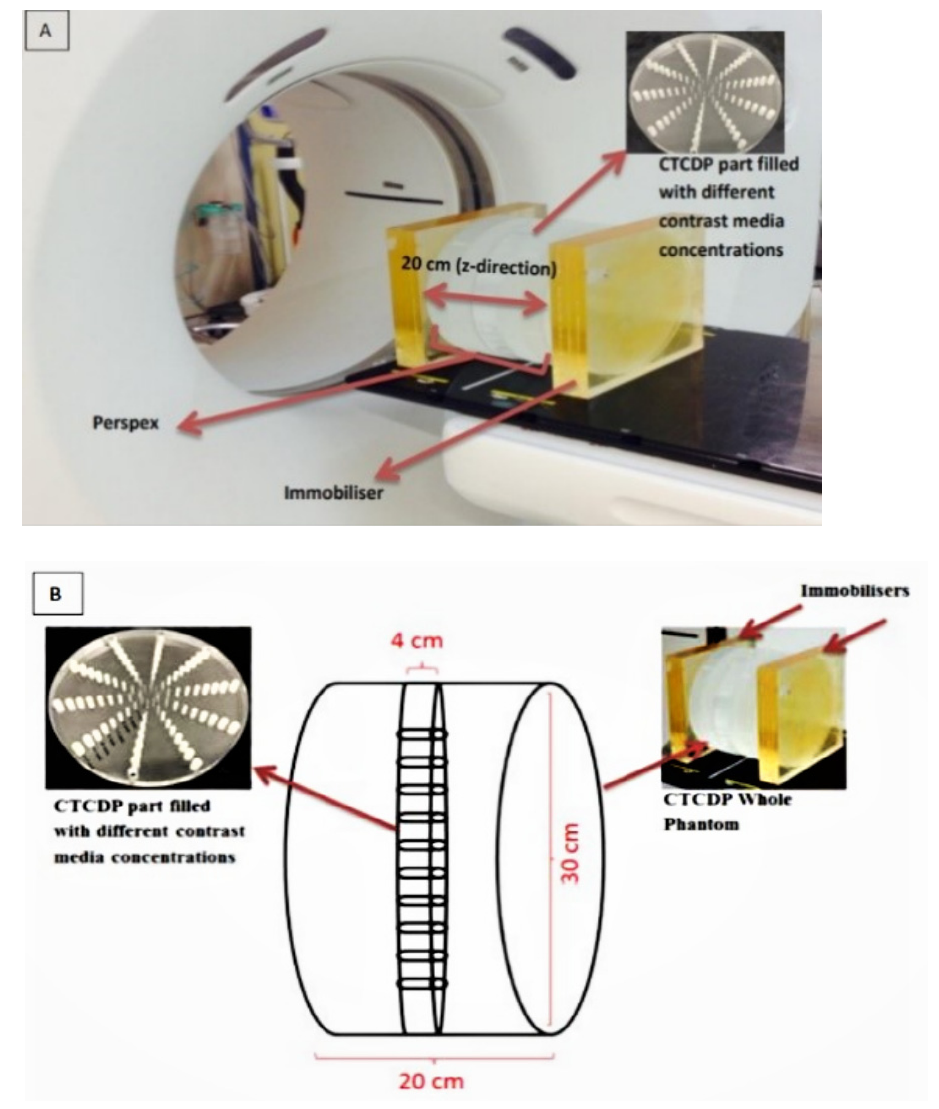
Figure 2. ( A ) Displays a typical slice from the phantom scan used in the process of scoring; ( B ) Contrast Detail Radiography Phantom (CTCDP)